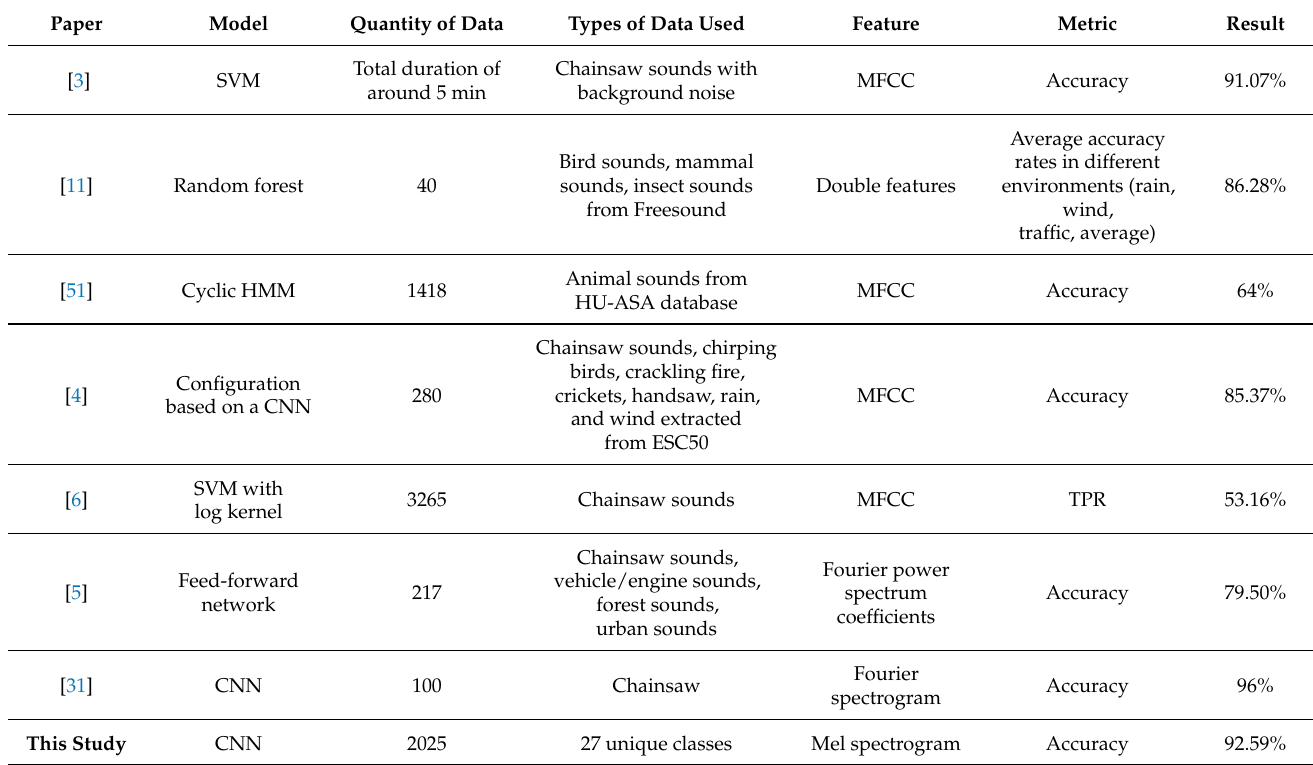
Table 9. Comparison of existing